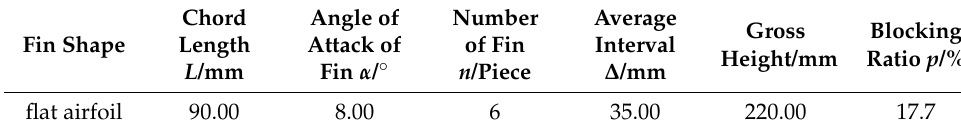
Table 6. Refined shutters’ key